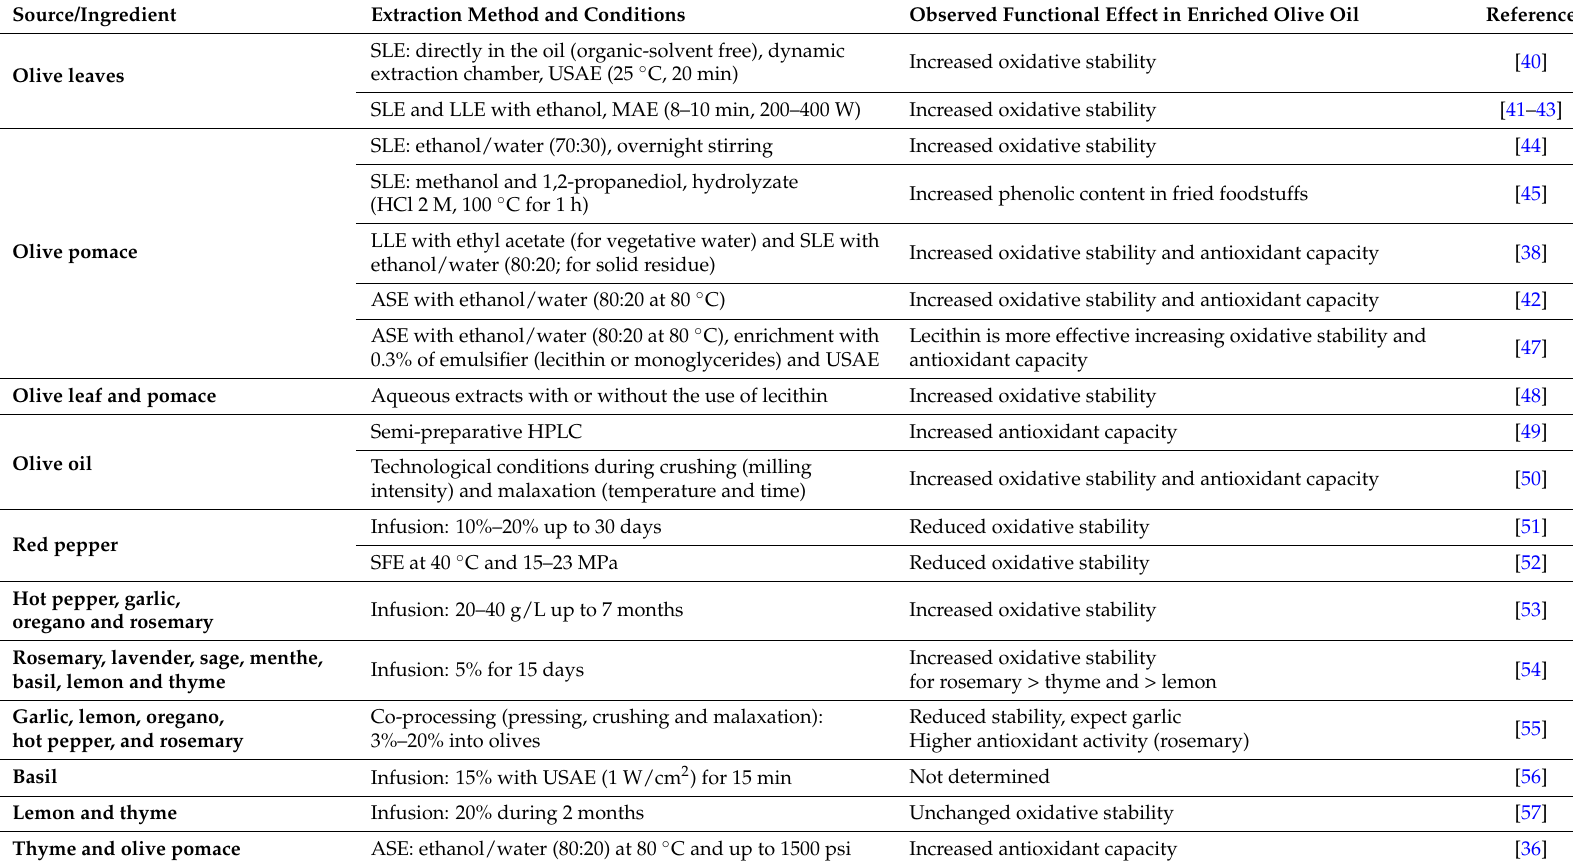
Table 1. Sources of natural bioactive ingredients and extraction conditions for the development of novel functional virgin olive oil